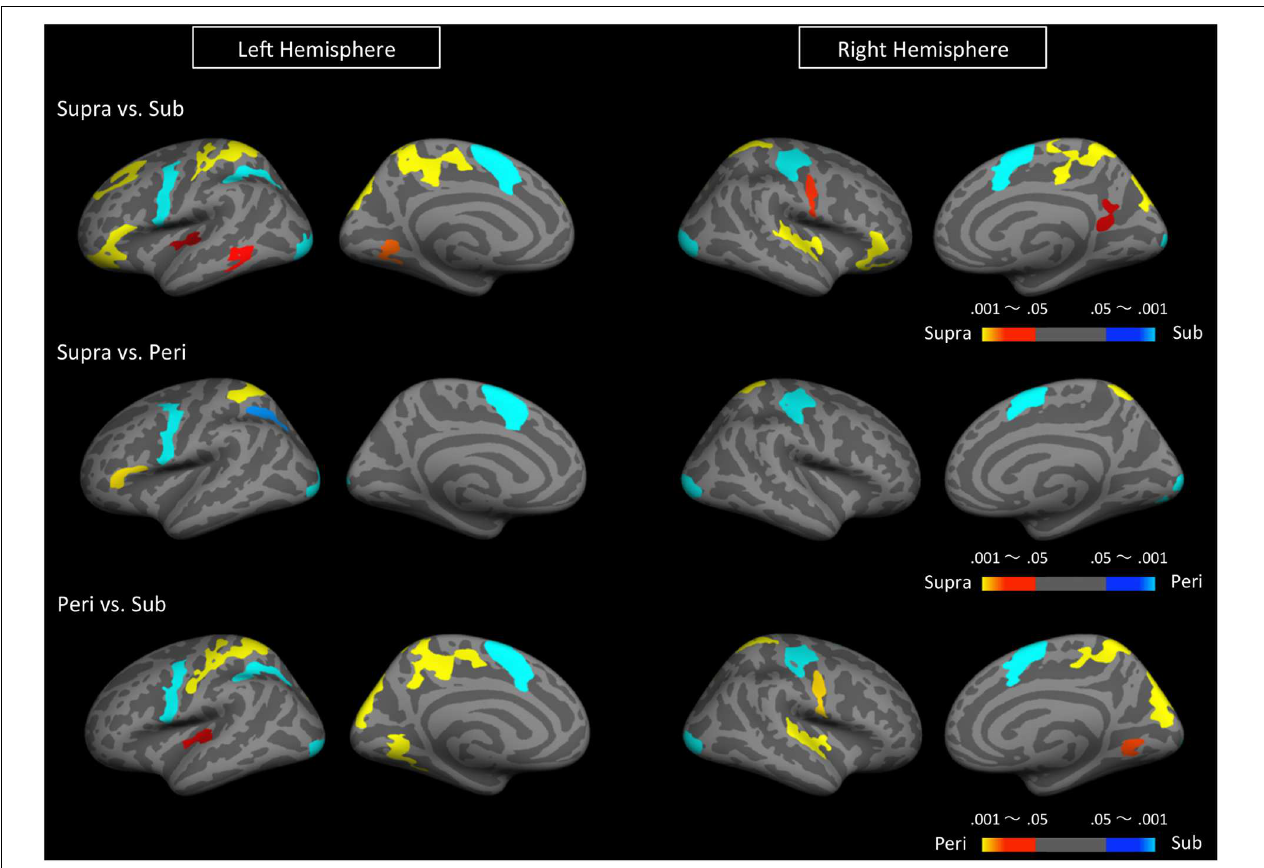
FIGURE 3 | Significantly activated clusters in sub-, peri-, and supra-second timing. The color scales indicate the cluster-wise corrected P -values.